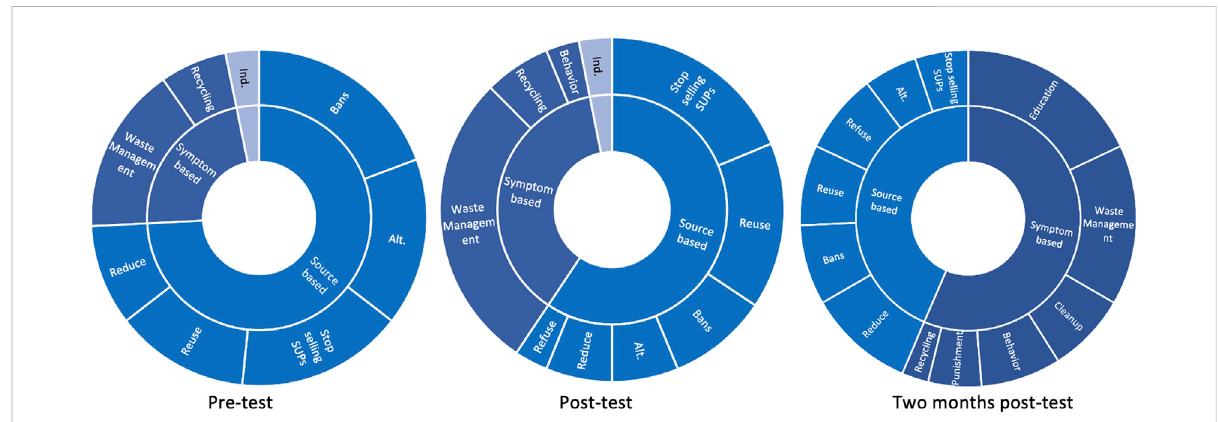
FIGURE 7 Stakeholder perceptions of policies in Indonesia, pre-test ( n = 31), post-test ( n = 32), and 2 months post-test ( n = 39). Alt. = Alternatives to plastic. Ind. = Indeterminate or